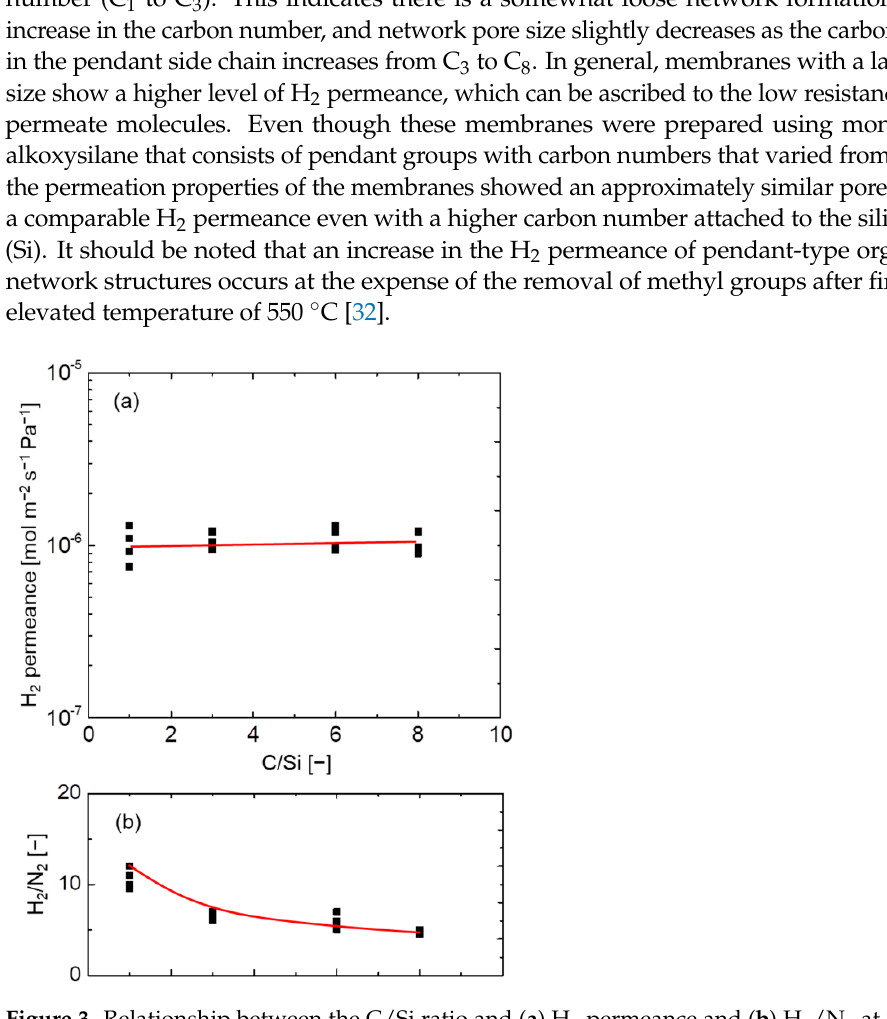
Figure 3. Relationship between the C/Si ratio and ( a ) H 2 permeance and ( b ) H 2 /N 2 at 200 °C for pendant–type organosilica membranes calcined at 300 °C under a N 2 atmosphere.